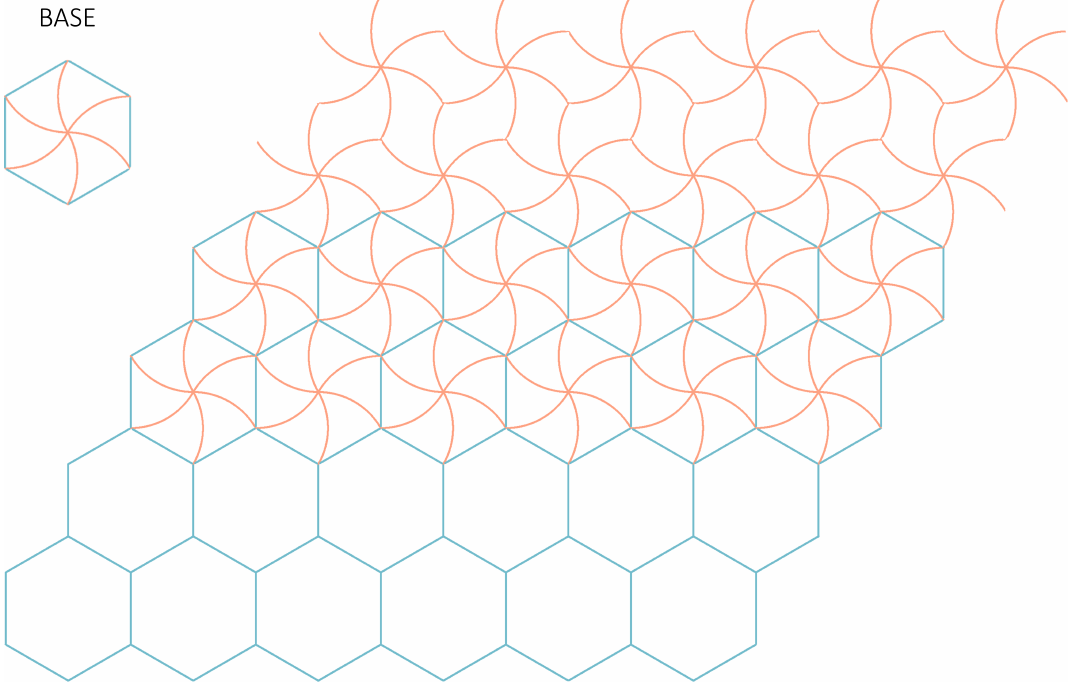
Figure 6. Basic shape and pattern